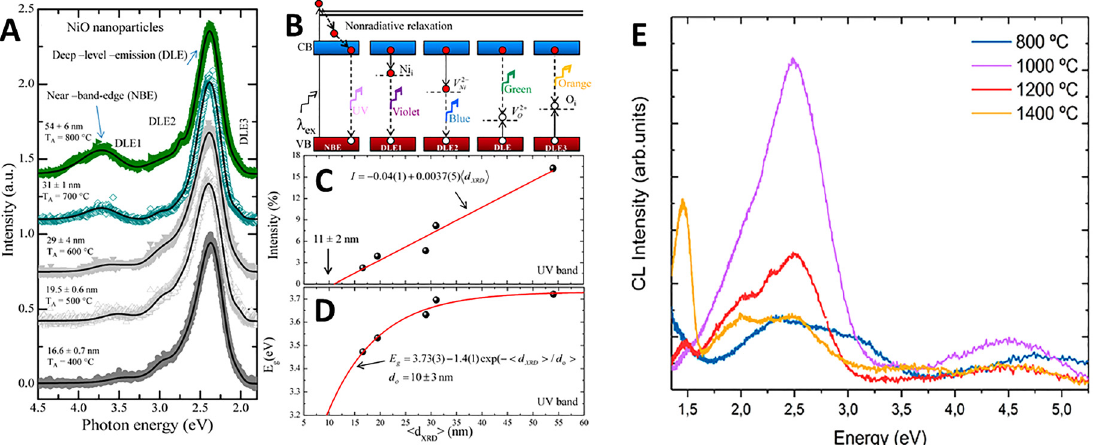
Figure 2: (A) Photoluminescence (PL) spectra from NiO showing dependence with the crystallite size. (B) Proposed electronic transitions between defect levels and bandgap of NiO nanoparticles. (C) Intensity of the UV emission and (D) bandgap energy as a function of the nanoparticles size, reproduced from Ref. [36]. (E) CL spectra acquired at 110 K from NiO samples sintered at 800, 1000, 1200 and 1400 ° C. Reprinted with permission from Ref. [45] Copyright 2020 American Chemical Society.